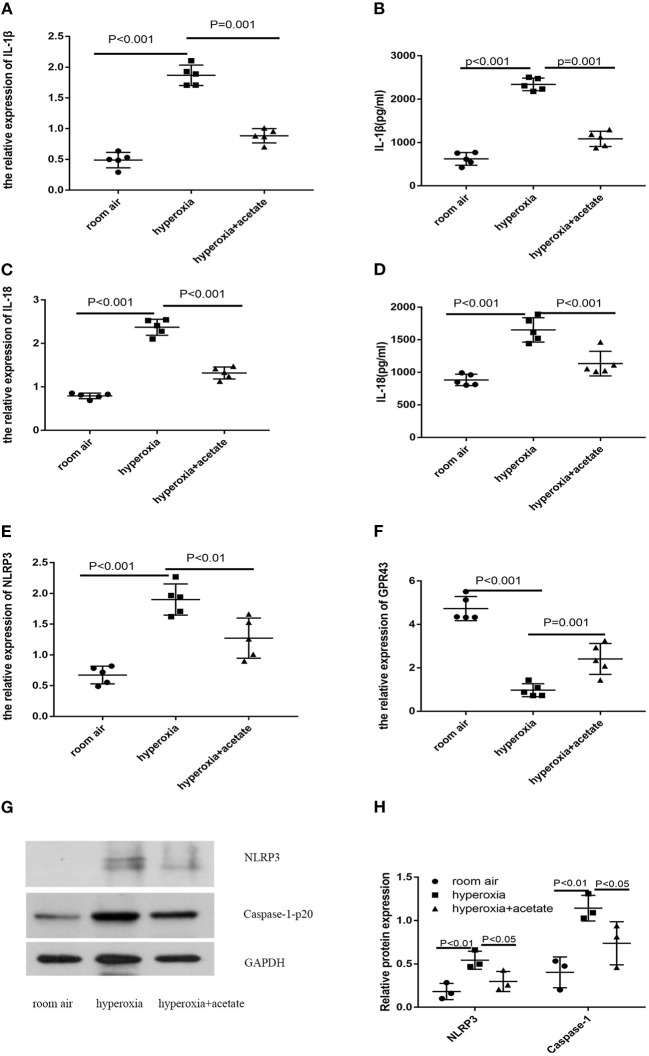
Acetate decreases NLRP3 inflammasome-related protein and GPR43 expression. The pulmonary mRNA levels of IL-1β (A), IL-18 (C), NLRP3 (E) and GPR43 (F). The pulmonary protein levels of IL-1β (B), IL-18 (D), NLRP3 (G,H) and caspase-1 (G,H). n ≥ 3/group from 3 independent experiments; data are presented as the means ± SD.